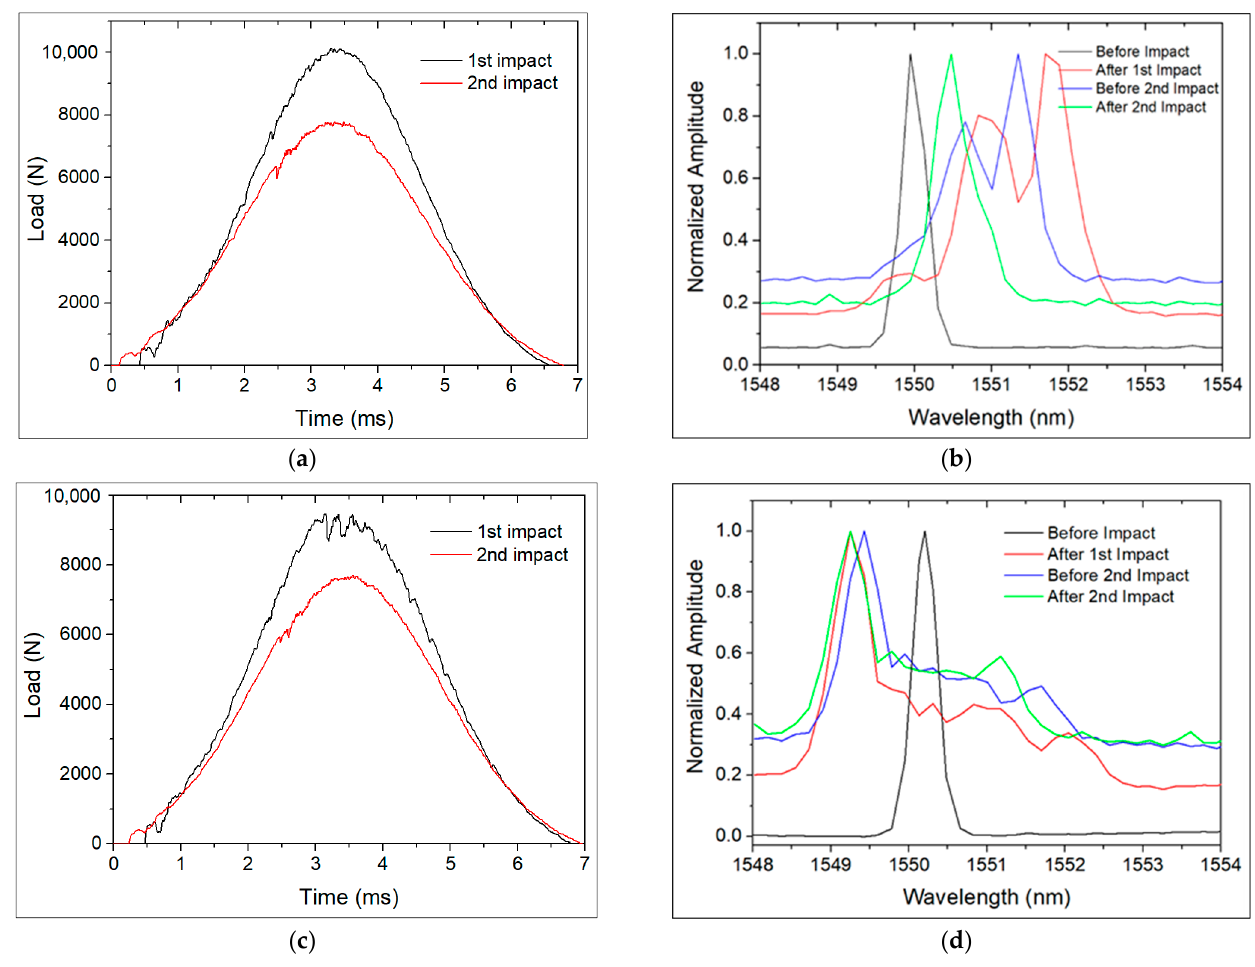
Figure 11. First (30.0 J) and second (20.0 J) low-velocity impacts on specimens with an LDOF with a Scheme 0 ( a ) and 002 ( c ), respectively, and ( b ), ( d ) corresponding changes on the FBG